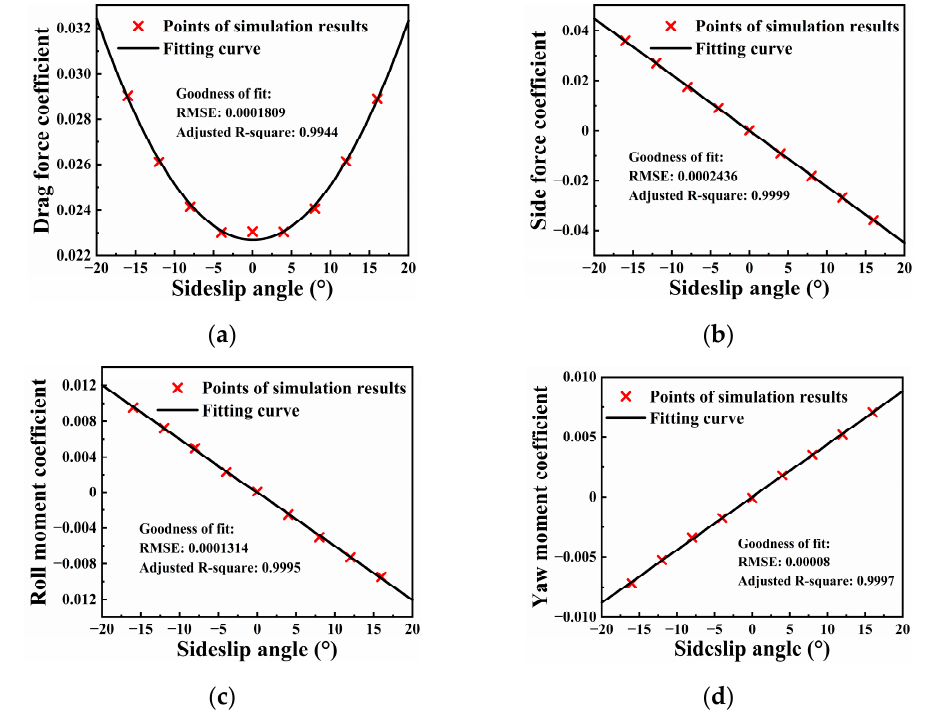
Figure 3. Curve fitting of aerodynamic coefficients versus the sideslip angle: ( a ) drag force; ( b ) side force; ( c ) roll moment; ( d ) yaw moment.